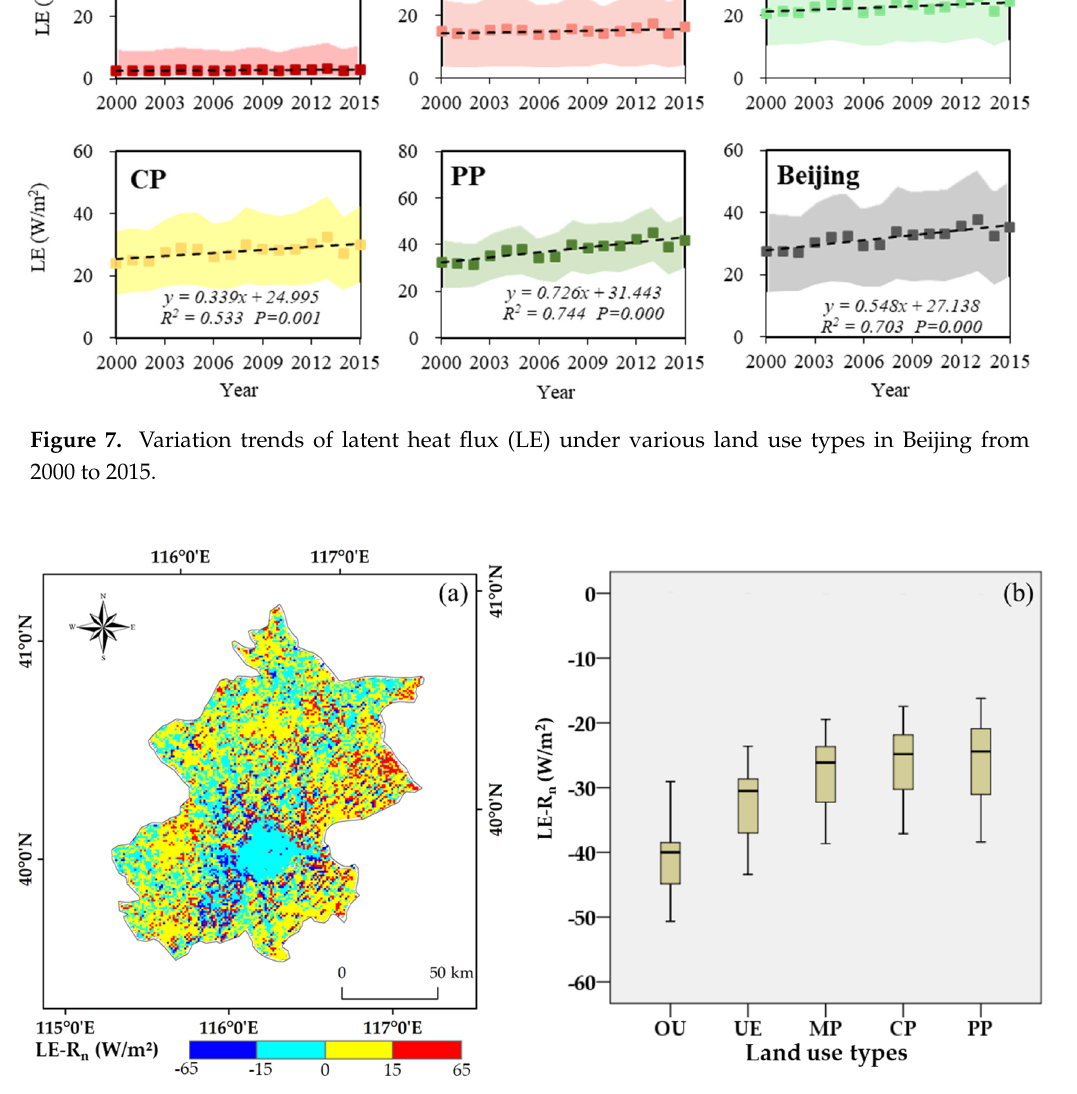
Figure 7. Variation trends of latent heat flux (LE) under various land use types in Beijing from 2000 to 2015.